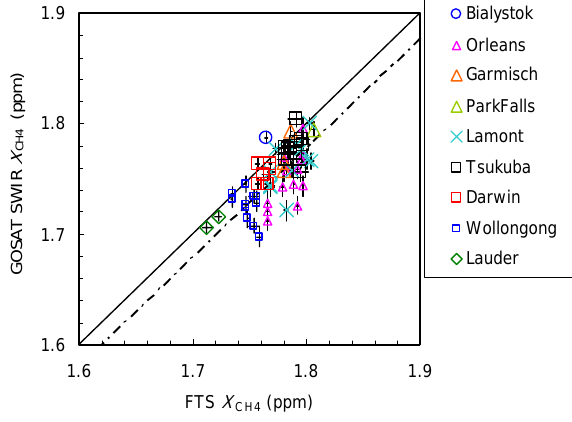
Fig. 7. Scatter diagram between GOSAT TANSO-FTS SWIR and g-b FTS X CH at all FTS sites. 4